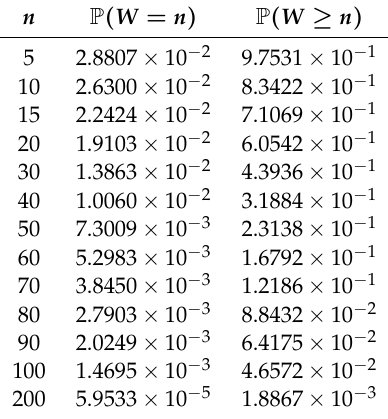
Table 5. The probability mass function P ( W = n ) and tail probability P ( W ≥ n ) for Example 1.